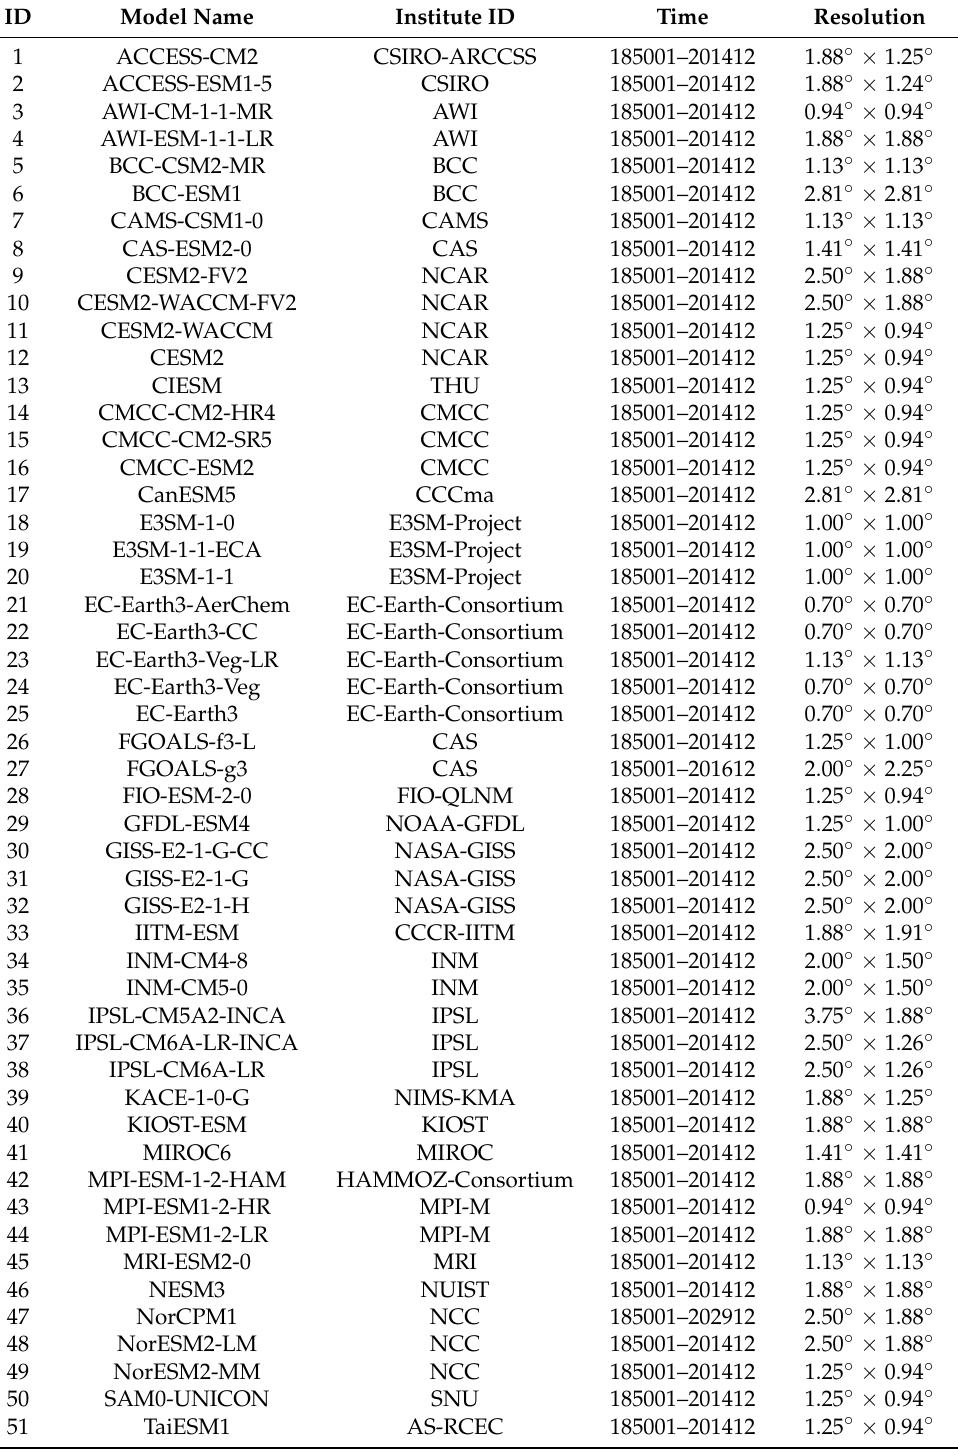
Table 2. Detailed information on the CMIP6 GCMs used in this